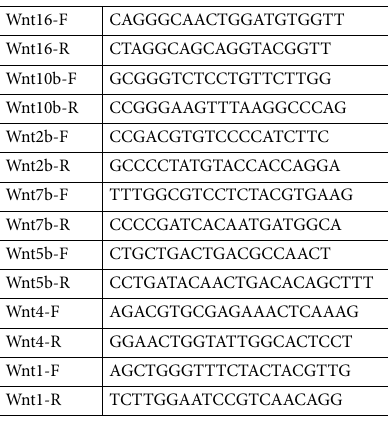
Table 1. Nucleotide sequences for RT-qPCR primers (5 ′ to 3 ′